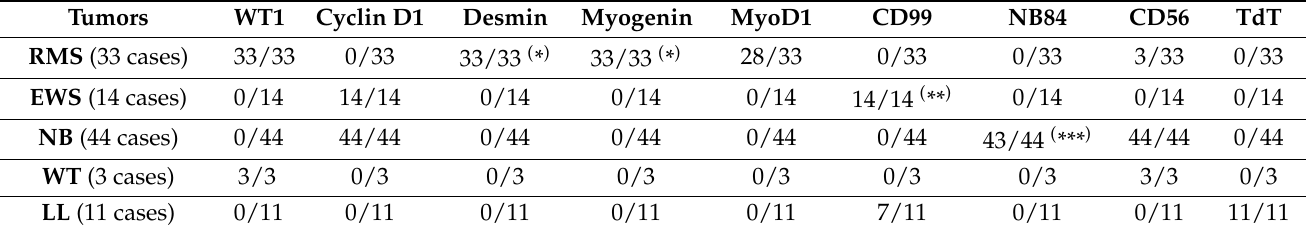
Table 2. Immunohistochemical results.